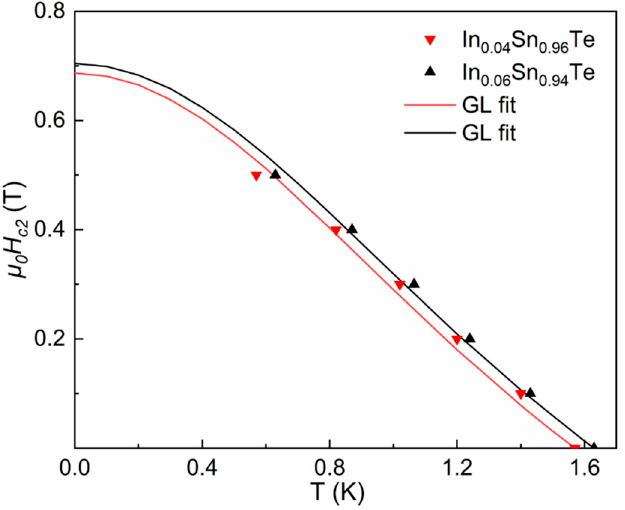
Figure 5. Temperature dependence of upper critical field H c 2 ( T ) for x = 0.04 and 0.06 crystals. The solid lines show Ginzburg–Landau (G–L) fitting.